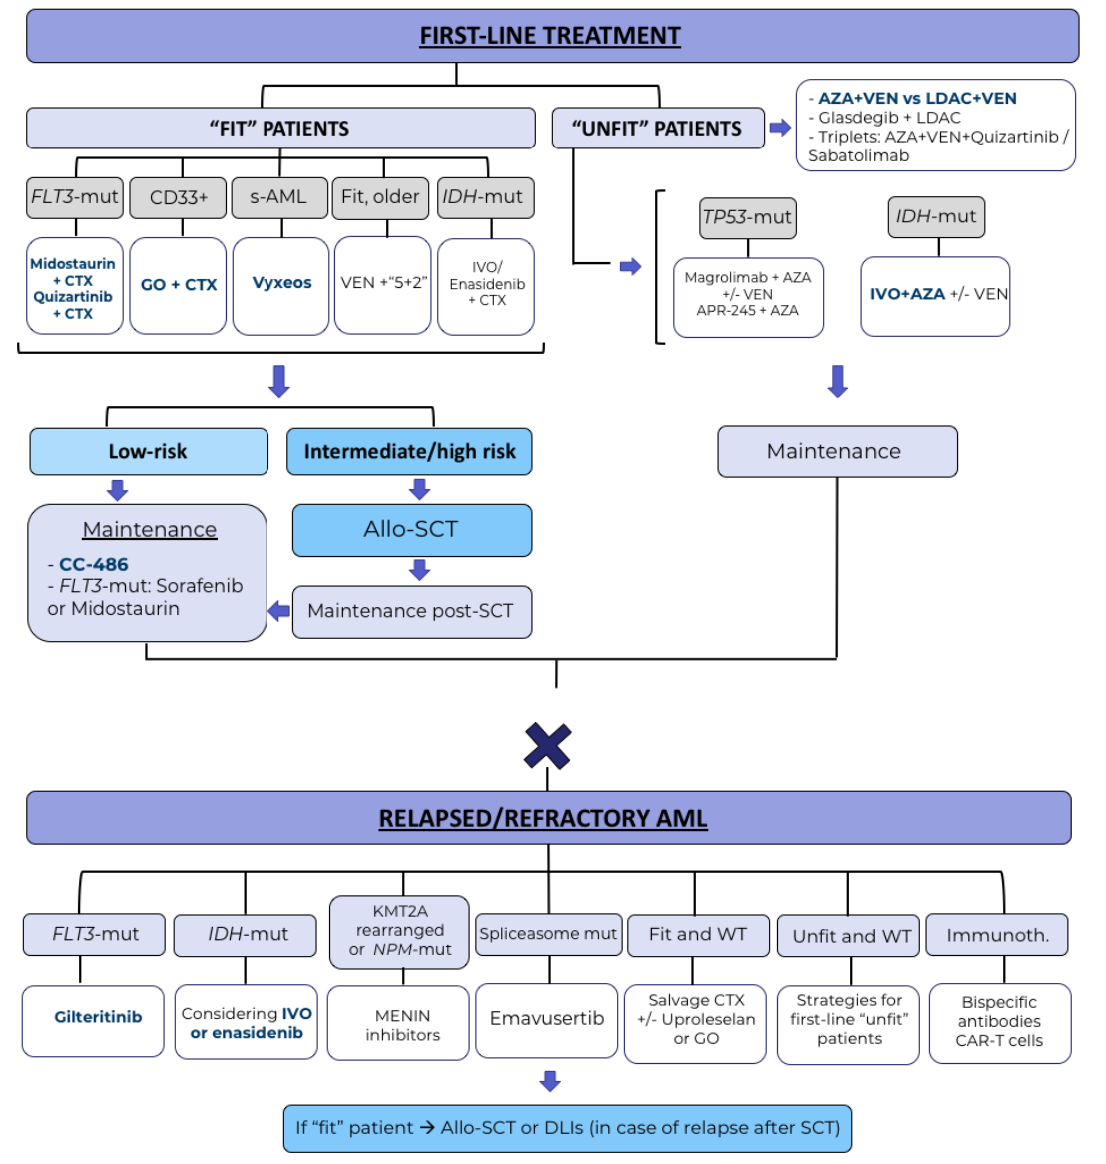
Figure 1. Projected roadmap for AML treatment in, the future. Treatment-combinations with phase III data are represented in blue. AZA: azacitidine; VEN: venetoclax; LDAC: low-dose cytarabine;